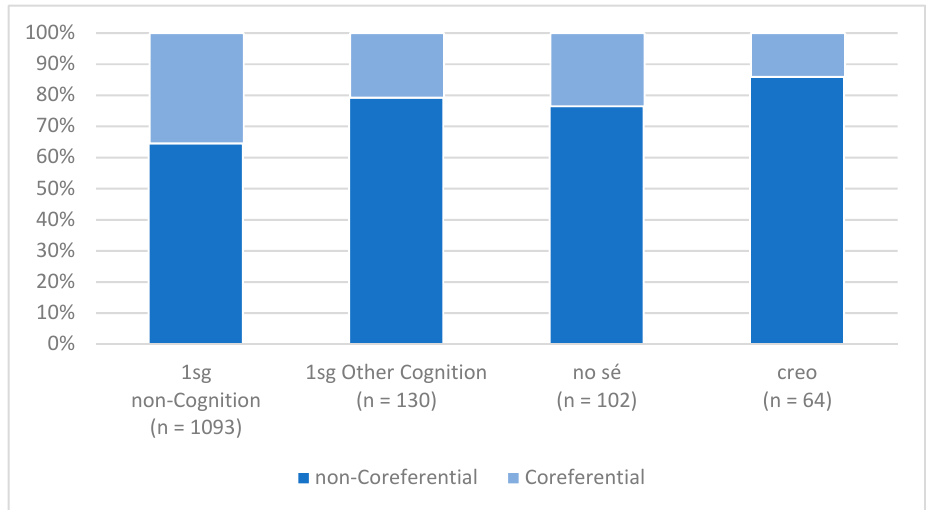
Figure 6. Data distribution for constructions by accessibility. Cognition verbs (especially (yo) creo ) occur disproportionately in non-coreferential contexts.